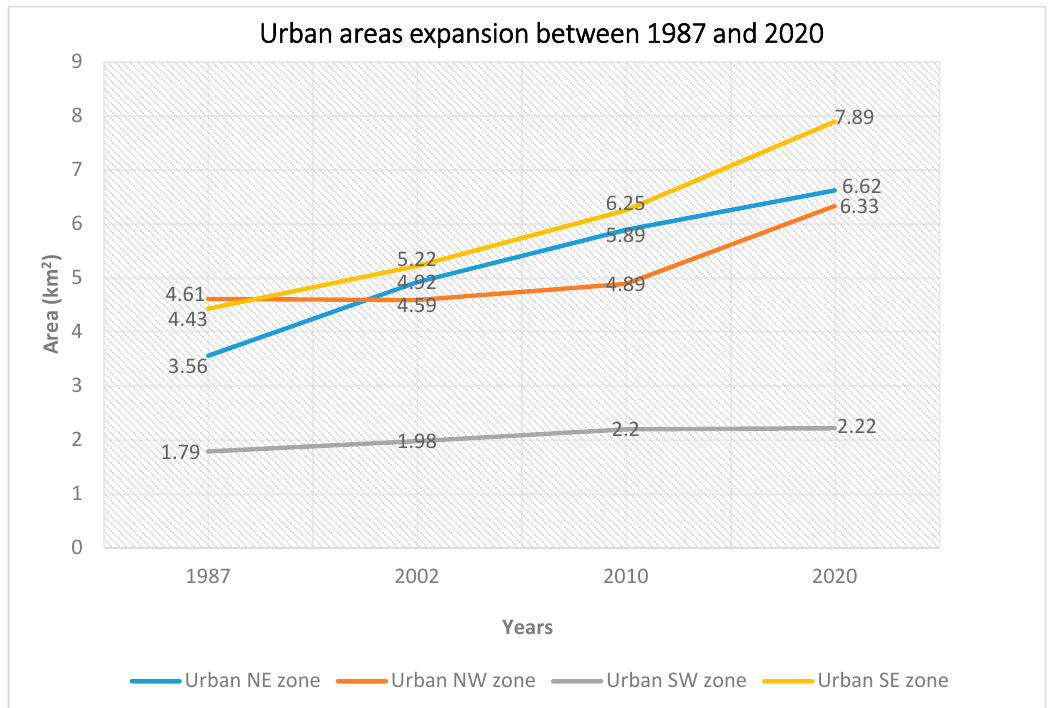
Figure 6. Urban area expansion in all zones between 1987 and 2020.